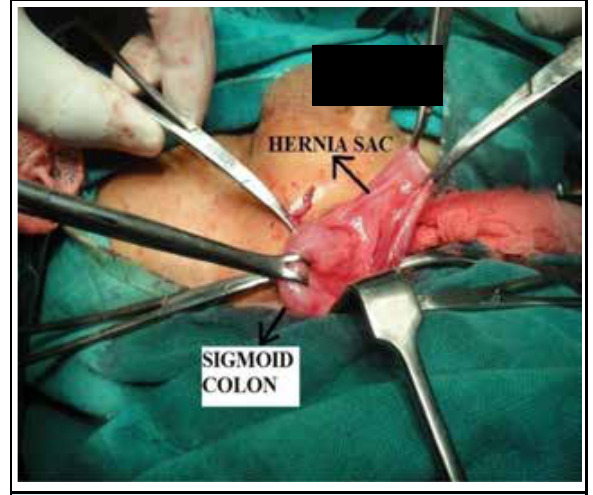
Figure 2. Hernia sac and sigmoid colon.